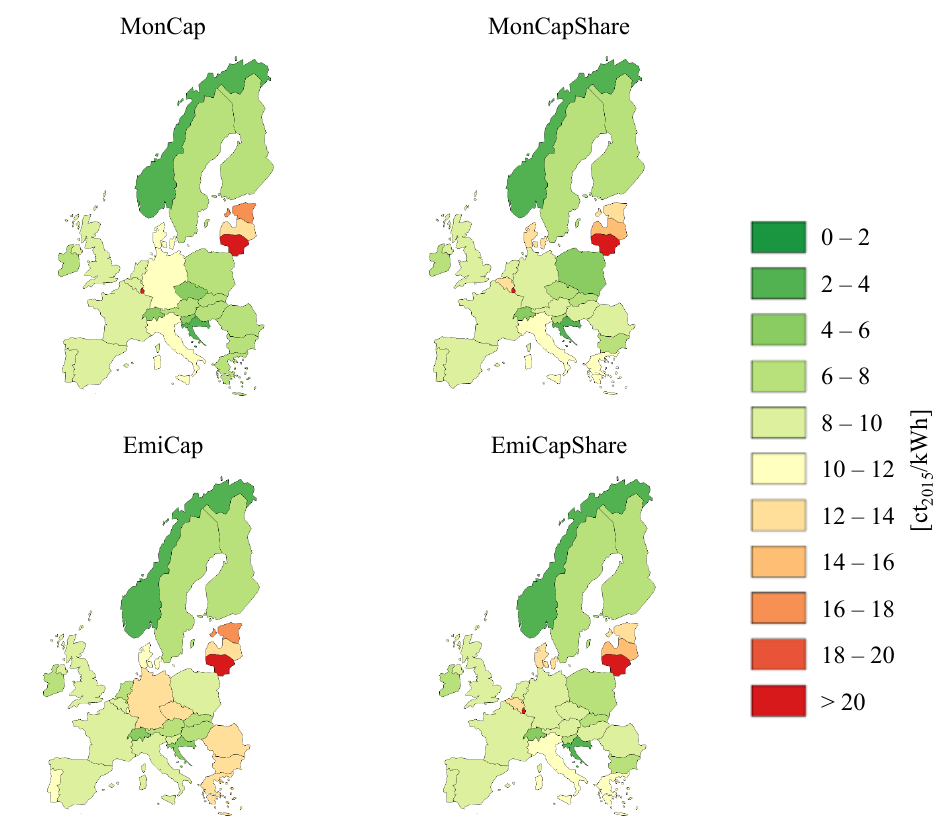
Figure 7. Levelized cost of electricity for the modeled region for given